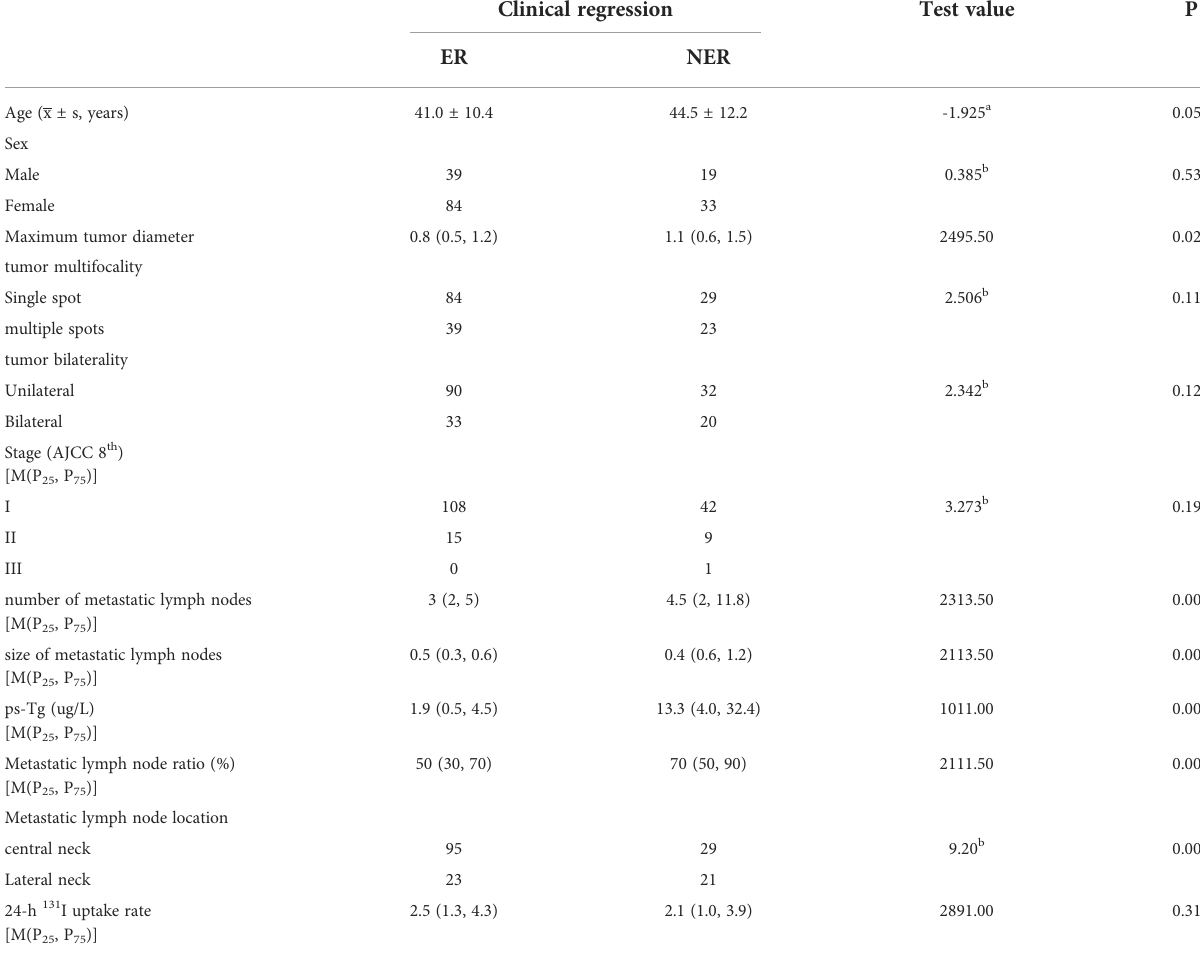
TABLE 1 Comparison between two divisions of individuals with papillary thyroid cancer in terms of general clinical data.